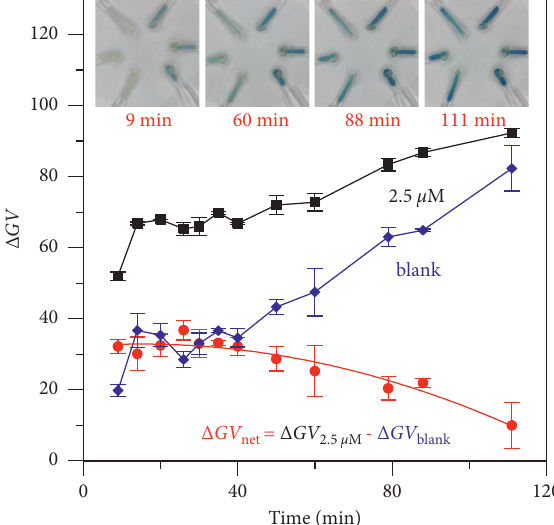
Figure 4: Effect of photographing time on the color intensities of 2.5 μ M standard and blank (PMB-HLB method, n ˆ